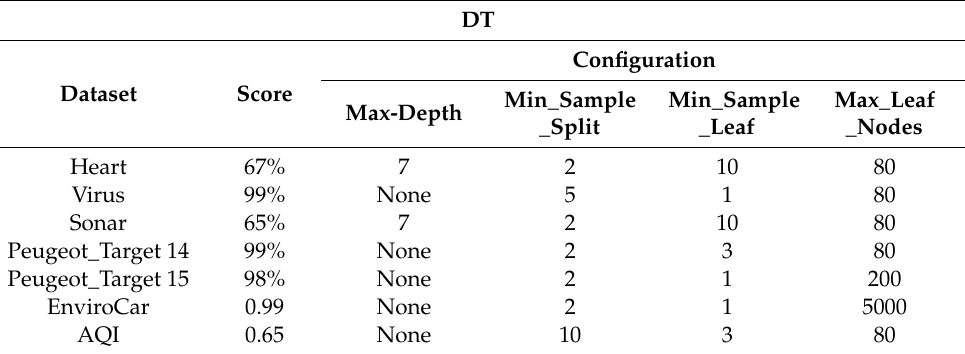
Table 24. DT performance and configuration for PCA = None.